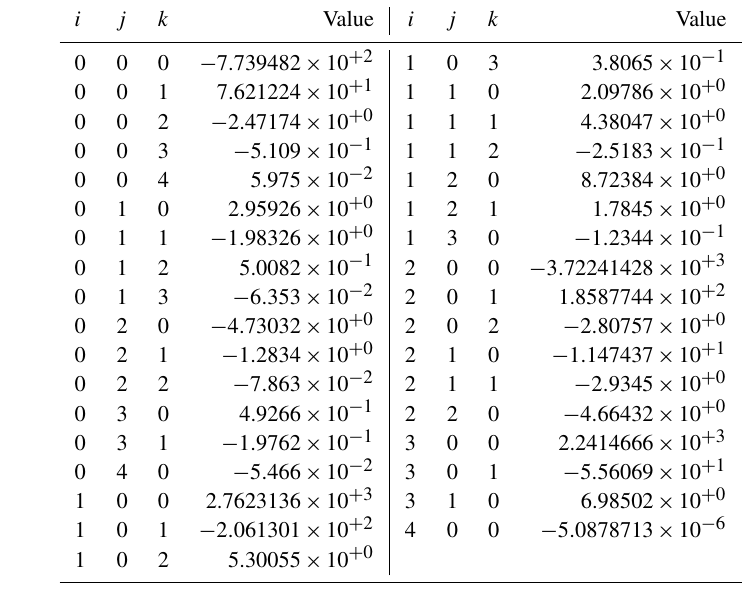
Table 5. Values of the coefficients b i,j,k of Eq.